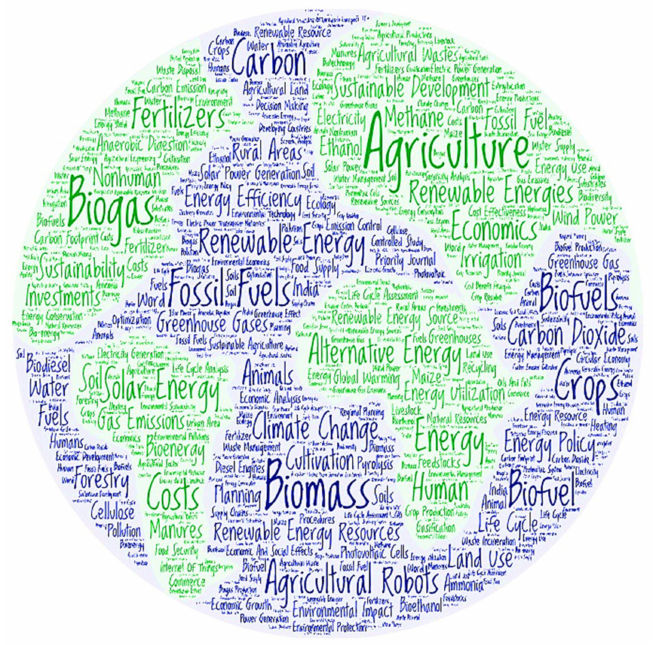
Figure 9. Keywords used in research on renewable energy applied in agriculture.